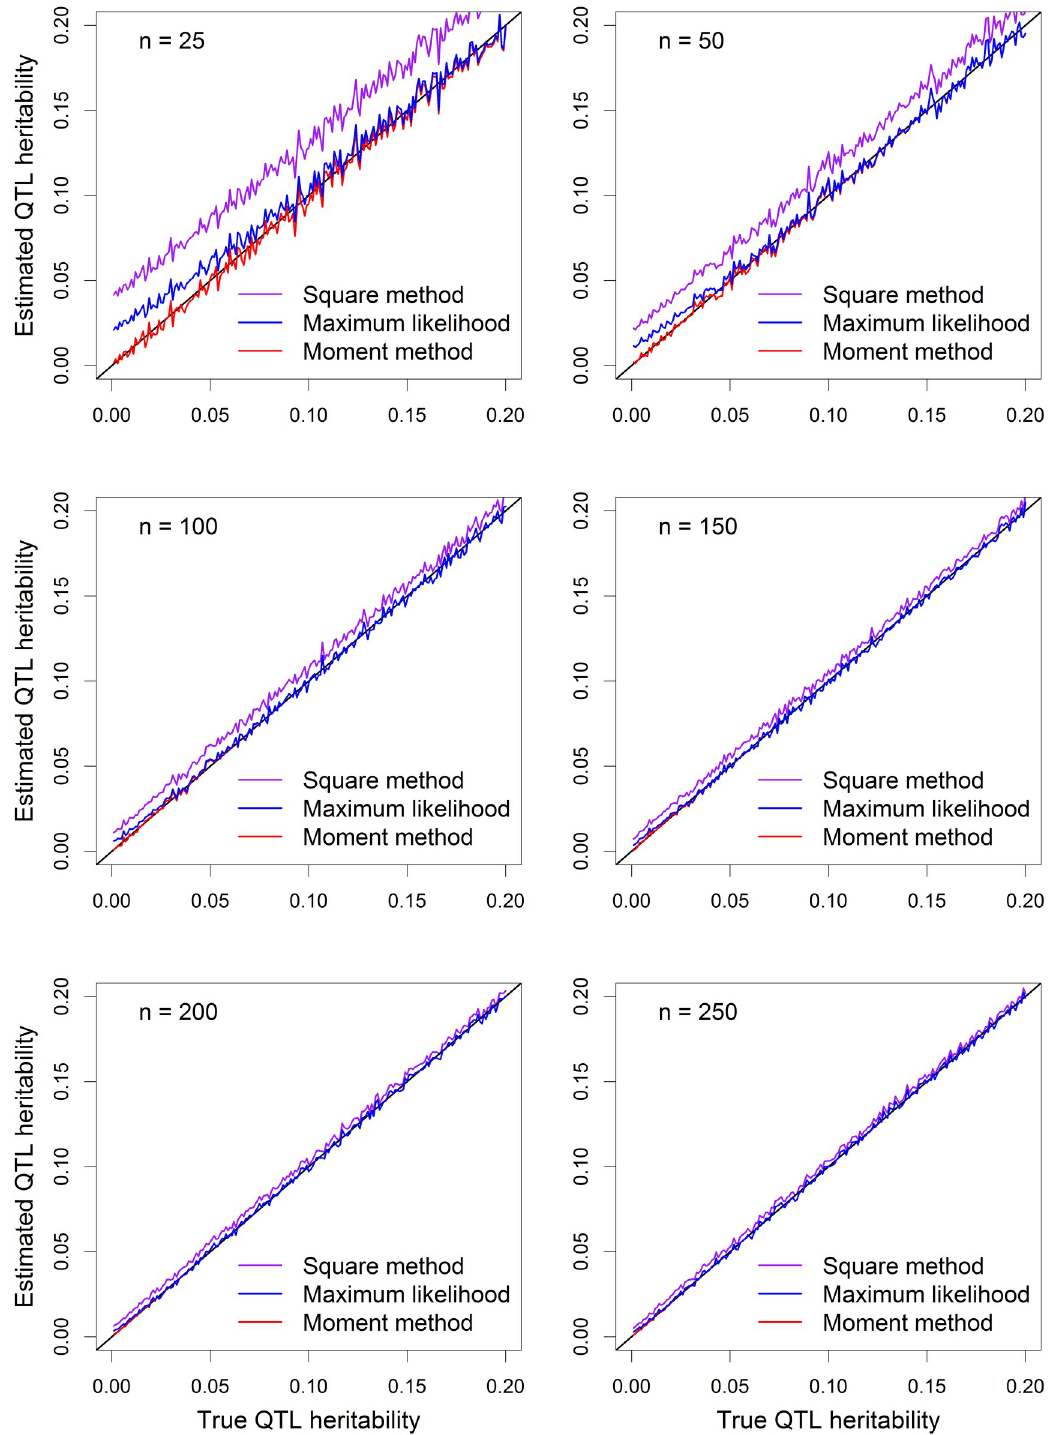
Fig 3. Plots of estimated QTL heritability from three methods against the true QTL heritability. The six panels of the figure show the results of six sample sizes ( n ), which are 25, 50, 100, 150, 200 and 250, respectively.